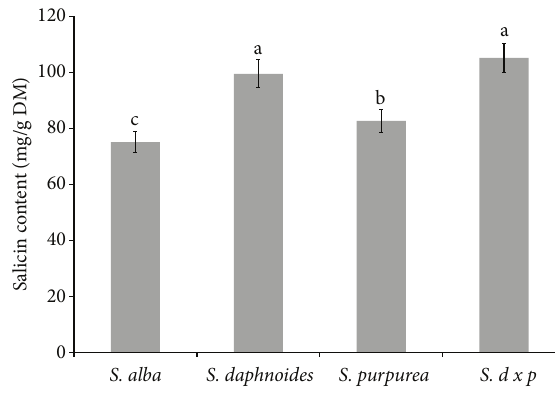
Figure 1: Comparison of phenolic glycosides content in Salix bark. Bars (means) followed by the different letters differ significantly (Tukey-test, 𝑃 < 0.05